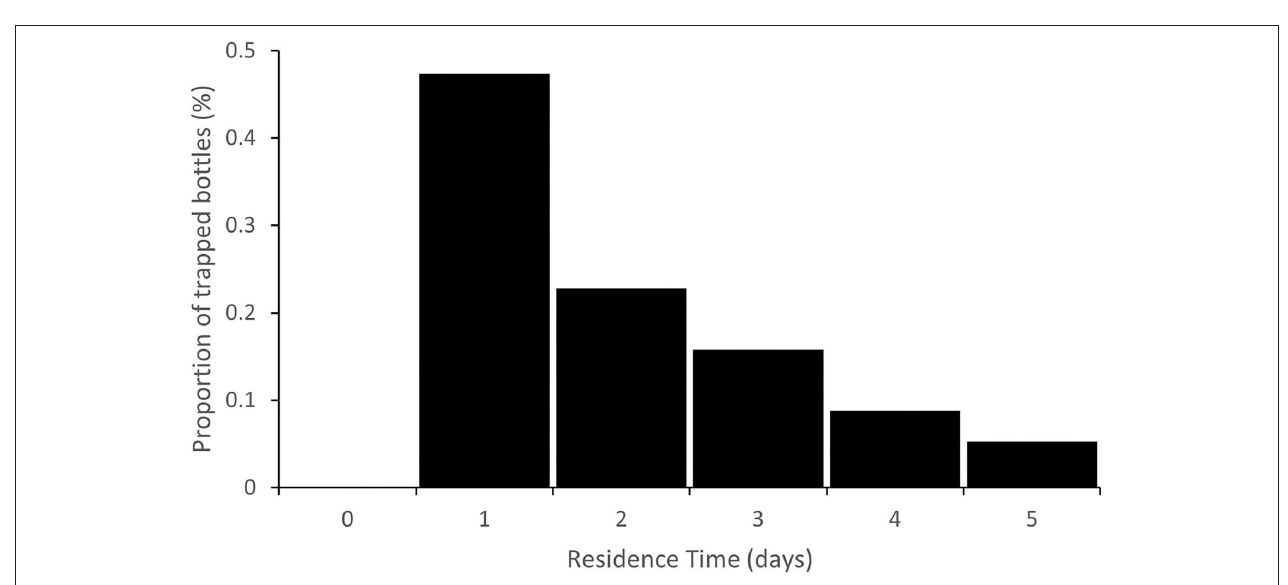
FIGURE 6 | Example residence time distribution at the sub-reach 20m downstream of the injection point, assuming q ( i ) = 0.5 for all traps.